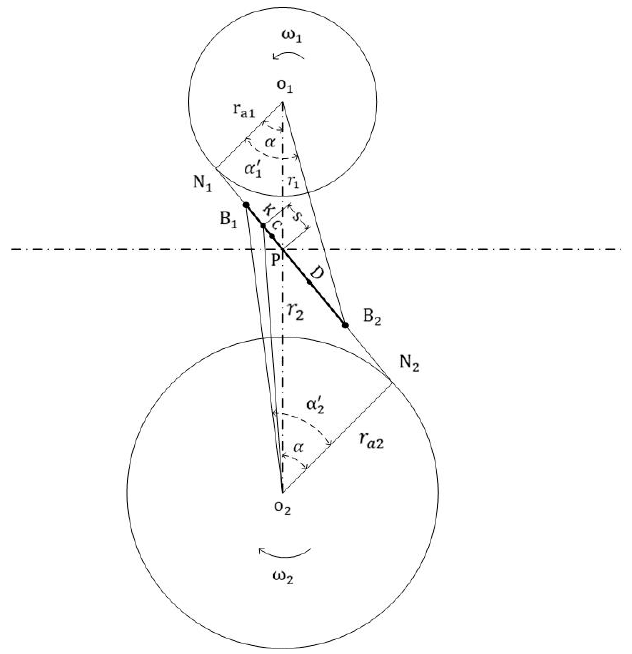
Figure 1. Meshing model of involute spur gear.